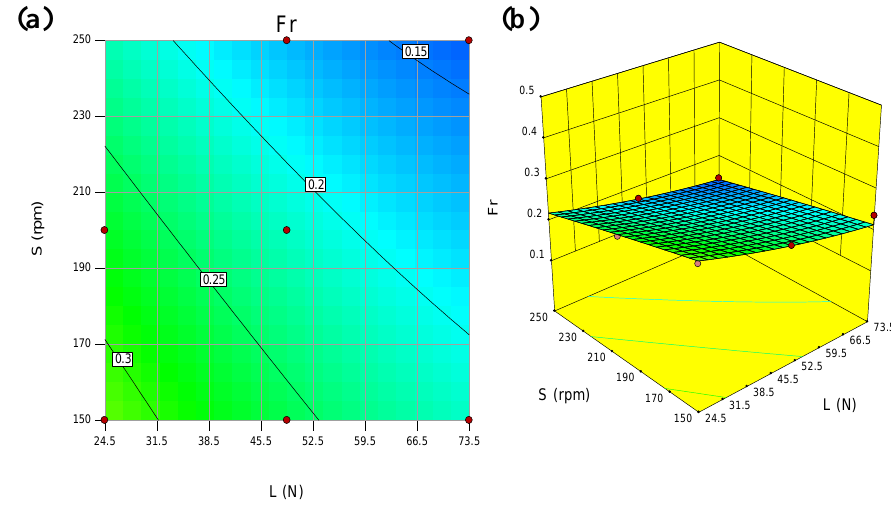
Figure 10. View of the interactive effect of S and L on F r , ( a ) contour lines 2D, ( b ) 3D.